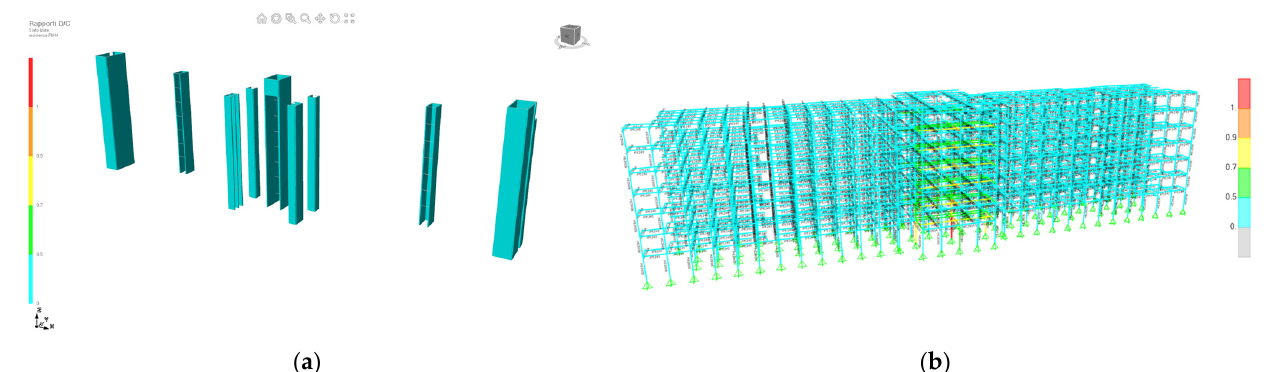
Figure 9. Demand-to-capacity ratios for the cores under combined bending and axial force ( a ).